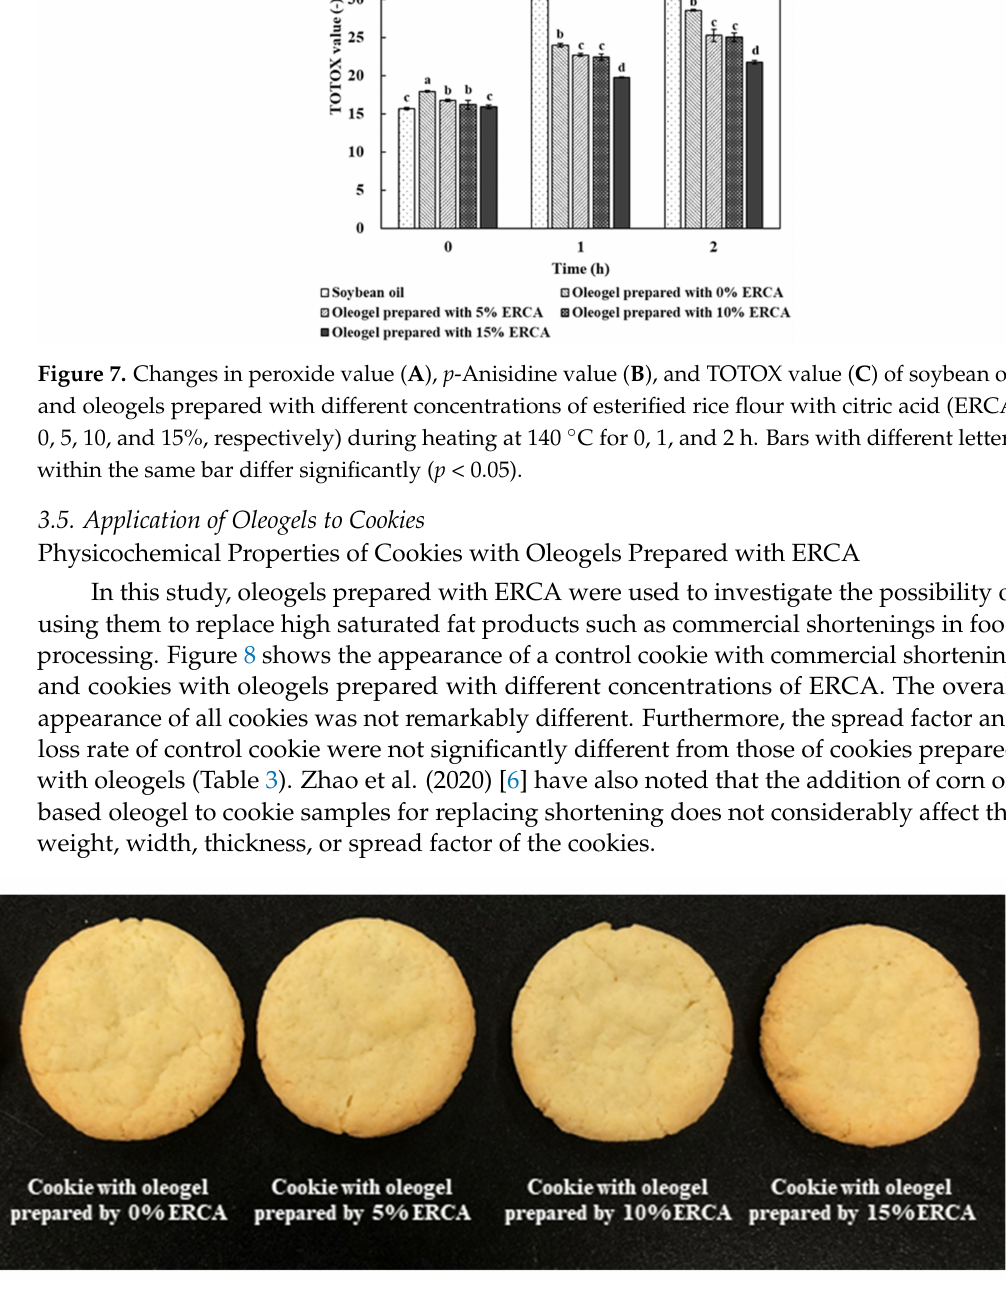
Figure 8. Appearance of control cookie and cookie with oleogel prepared by different concentrations of esterified rice flour with citric acid (ERCA; 0, 5, 10, and 15%,